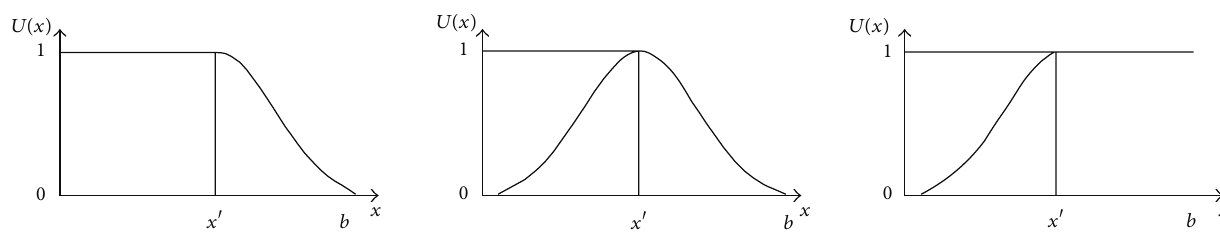
Figure 1: The typical whitenization weight function of normality grey number.